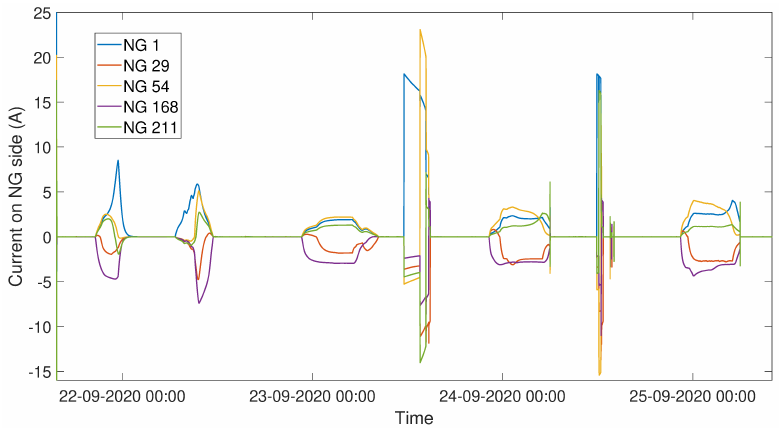
Figure 10. Evolution of the currents exchanged between the NGs—microgrid connection mode.